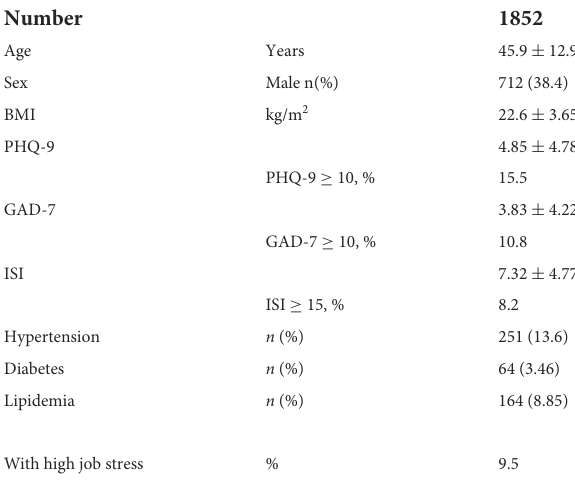
TABLE 1 Characteristics of